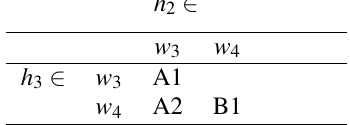
Table 5. Different Cases of Structure of D 2 α ( g ) when g = h 2 ∈